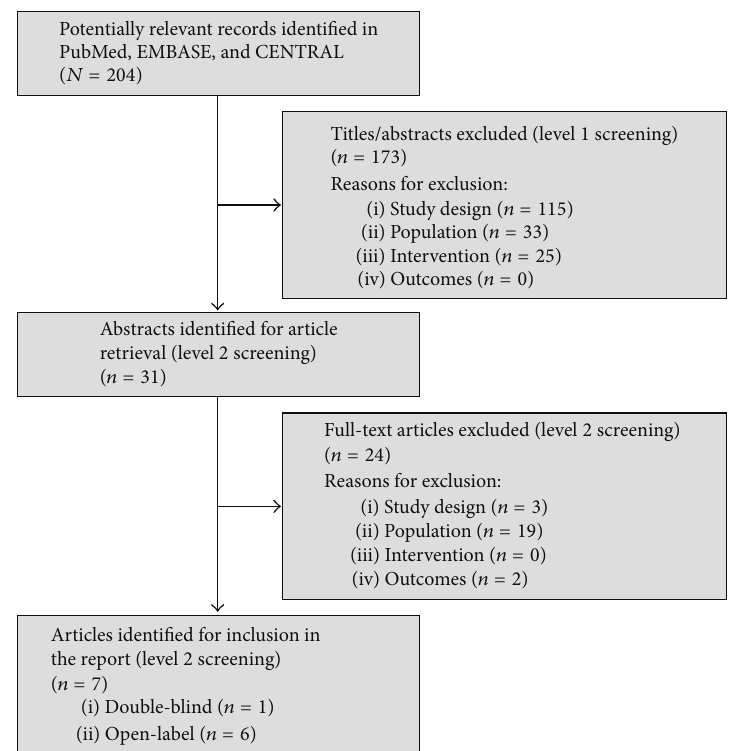
Figure 1: PRISMA flow diagram, Amendment 1. CENTRAL: Cochrane Central Register of Controlled Trials; PRISMA: Preferred Reporting Items for Systematic Reviews and